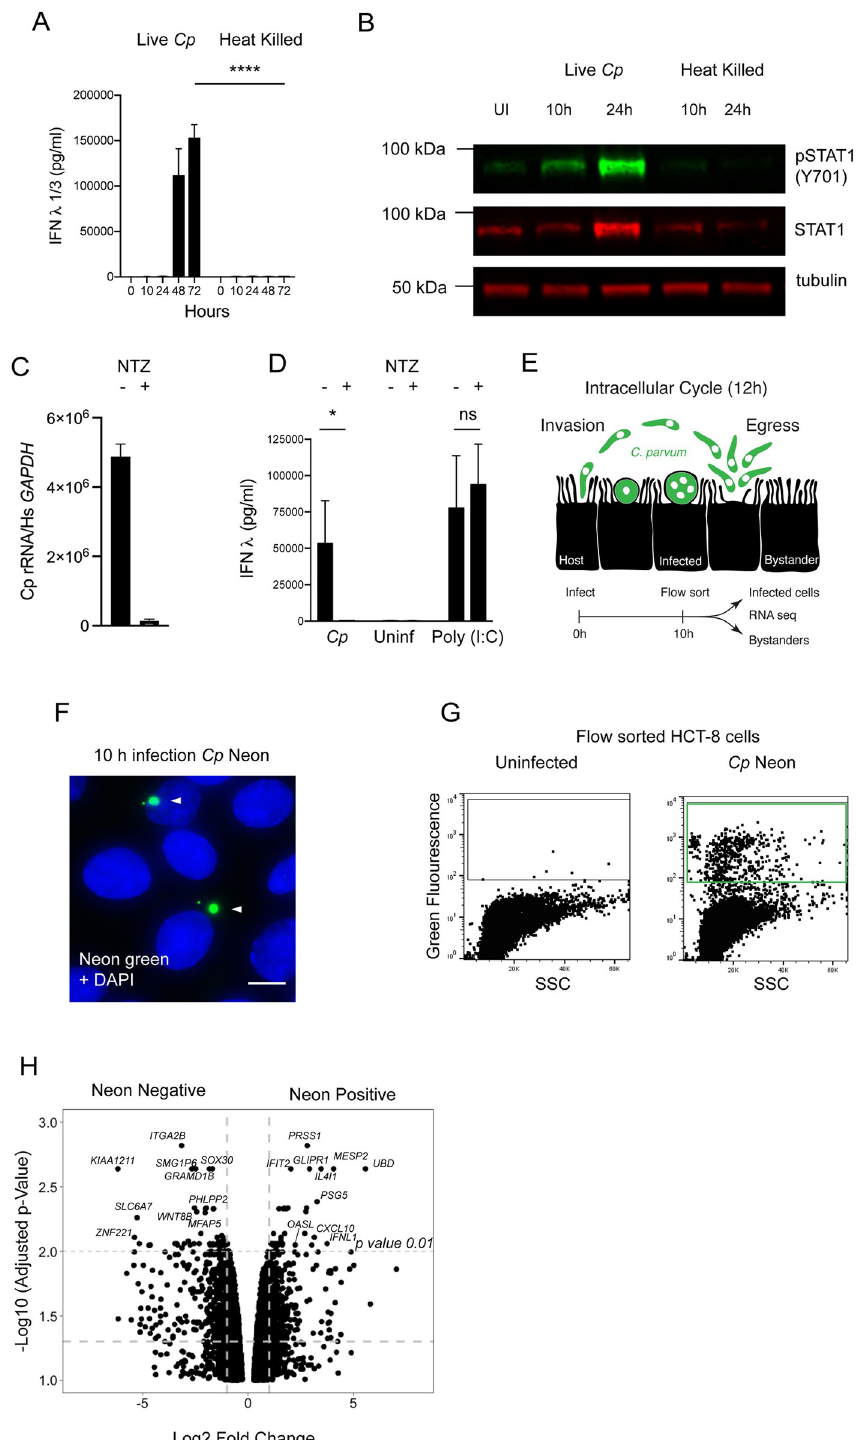
Fig 3. IFN-lambda production requires live infection and is initiated by infected cells. We examined the requirements and kinetics of initiation of the type III interferon response to C . parvum . (A) 24 well HCT-8 cultures were infected with 200,000 C . parvum live or heat killed oocysts and protein levels of IFN λ were assessed by ELISA. At 48 and 72 hours post infection the difference between live and heat killed was highly significant. Two-way ANOVA with Sˇı´da´k’s multiple comparisons test ���� p < 0.0001. n = 3. (B) Immunoblot comparing induction of STAT1